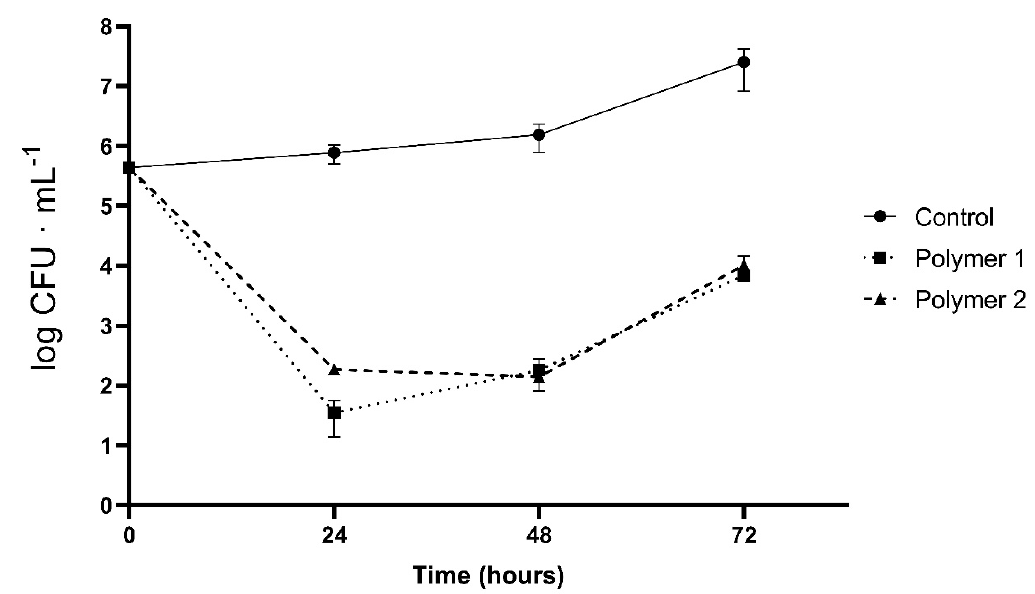
Figure 5. Antibacterial activity of polymers against Listeria innocua over 72 h of incubation. Control: growth without polymer. Polymer 1: polymer formulated with chitosan only. Polymer 2: polymer formulated with chitosan and fish gelatin. The results are expressed as log CFU·ml − 1 .